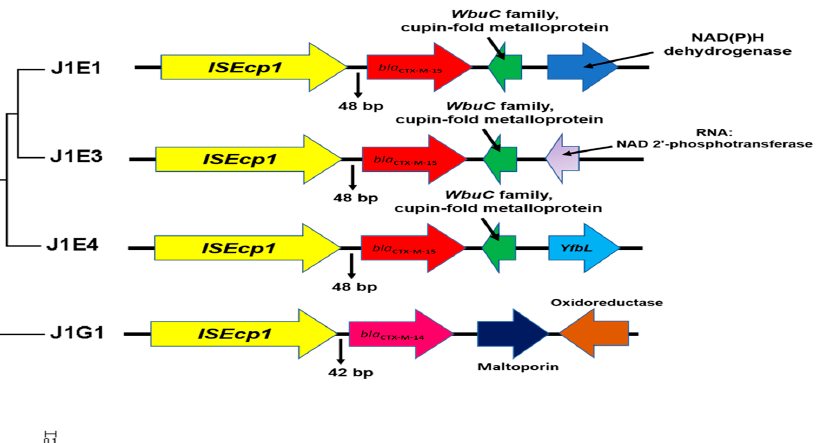
Figure 2. The genetic environment surrounding bla CTX ‐ M genes located on the chromosome. The maximum likelihood tree was built based on the alignment of 5000 bp fragments contain insert sequence and bla CTX ‐ M gene extract from the chromosome. The gene annotation and direction were generated by the RAST server and further corrected with NCBI blast. The conversed gene cluster contains ISEcp1 , bla CTX ‐ M ‐ 15, and WubC family metalloprotein. Table 5. The minimum inhibitory concentration (MIC) comparison among J1E4, J53, and the transconjugants. The mcr ‐ 1 gene was successfully conjugated to the J53 strain and confirmed with the PCR test. Interestingly, as tested with beta ‐ lactamase genes specific primer on the transconjugants, a co ‐ existing of the bla TEM ‐ 1 gene was found, but not the bla CTX ‐ M ‐ 15 gene. The co ‐ conjugation maybe because these two genes were both predicted to be located on plasmids, while the bla CTX ‐ M ‐ 15 gene was predicted to be chromosome ‐ located instead by